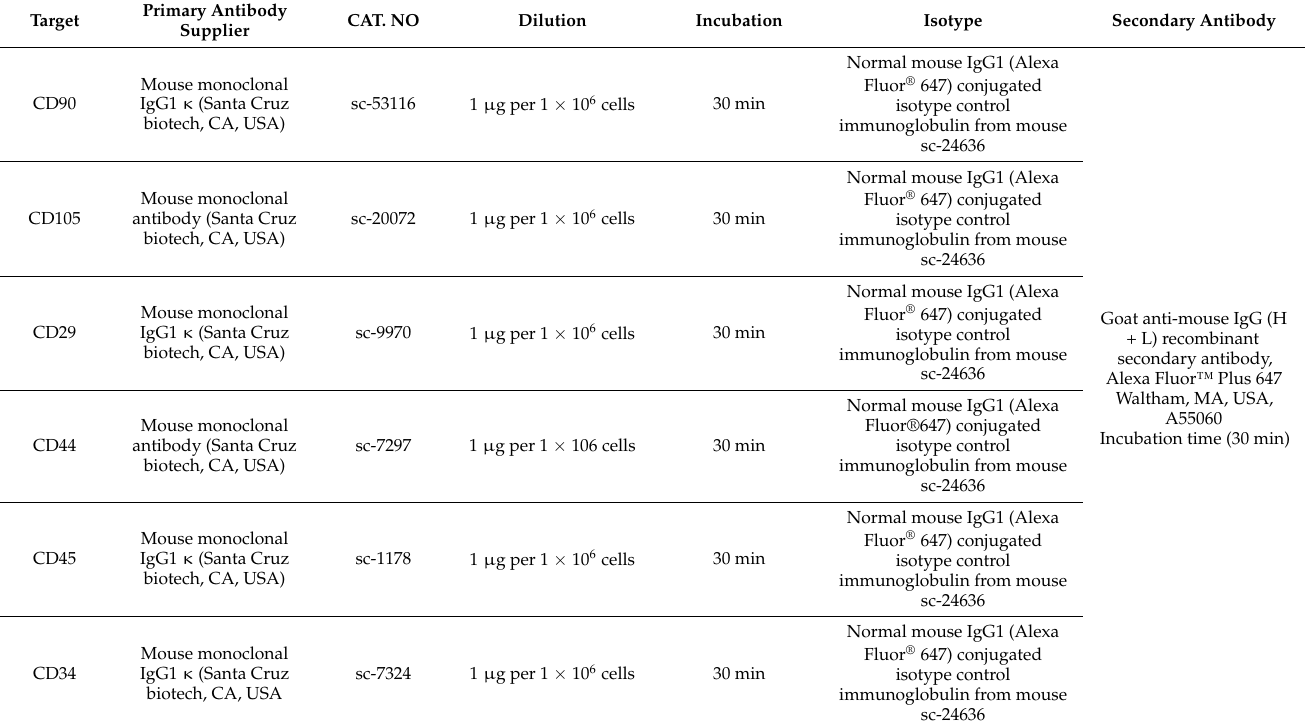
Table 1. Identity, sources, and working dilution of antibodies used in immunophenotyping